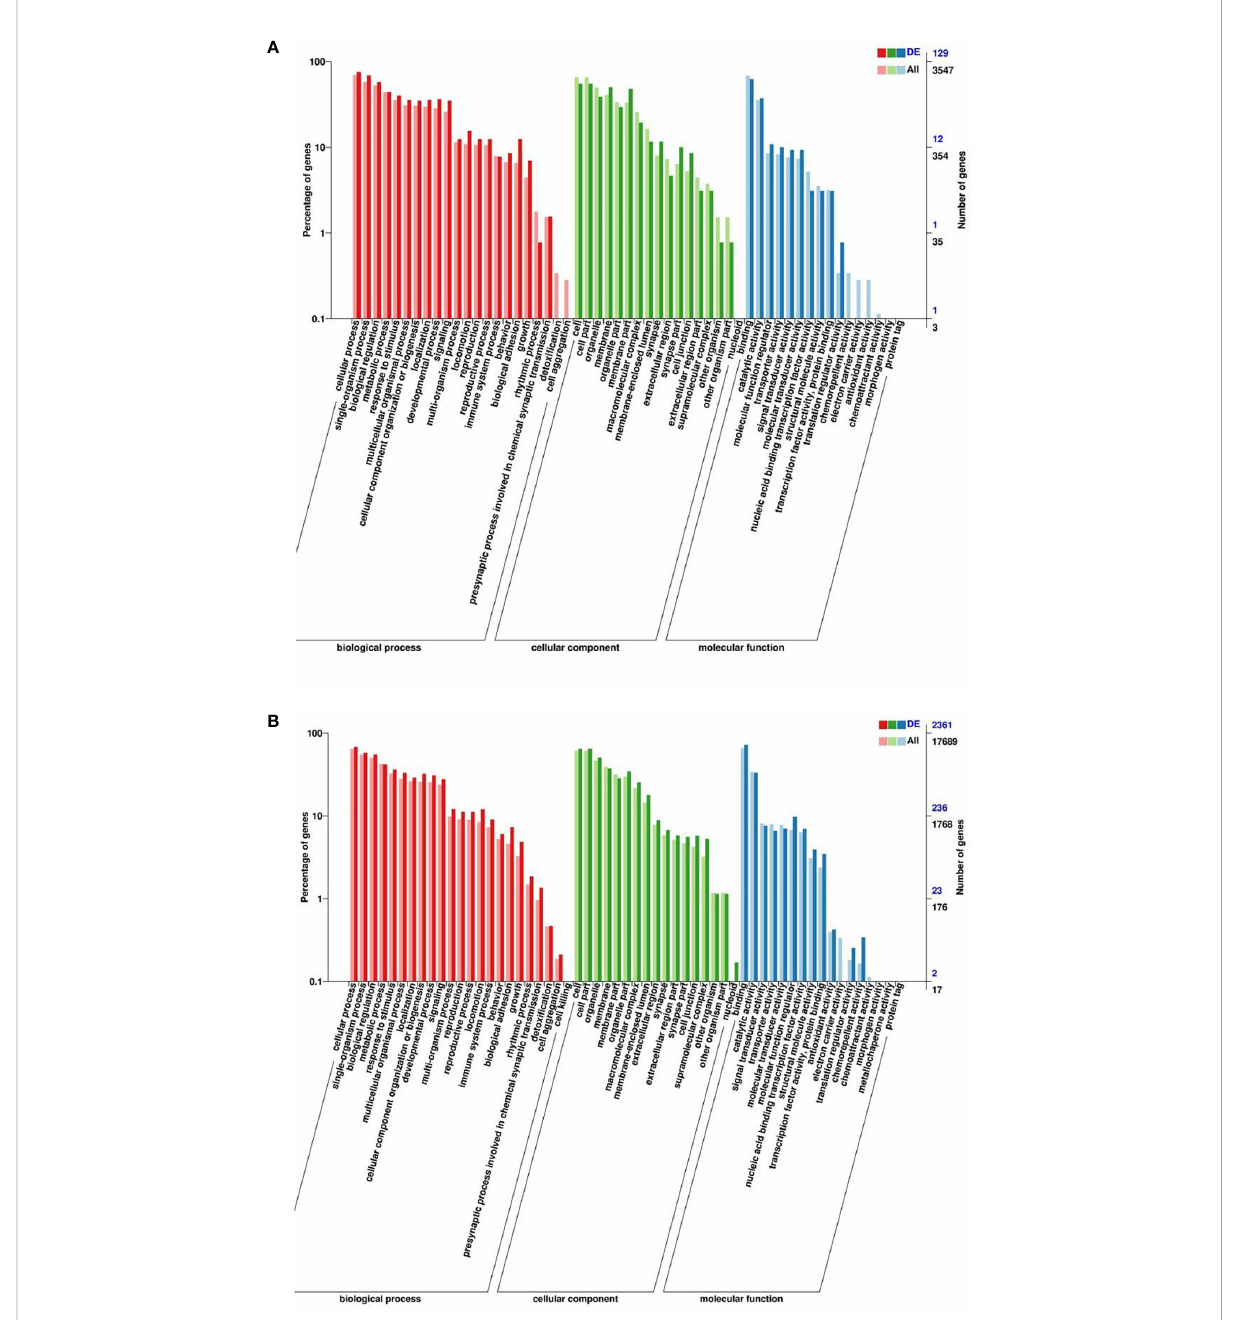
FIGURE 3 GO enrichment analysis of the host genes of DE circRNAs and the target genes of DE miRNAs. GO enrichment of the host genes of DE circRNAs (A) and the target genes of DE miRNAs (B) . The terms representing biological process, cellular component, and molecular function are in red, green, and blue,